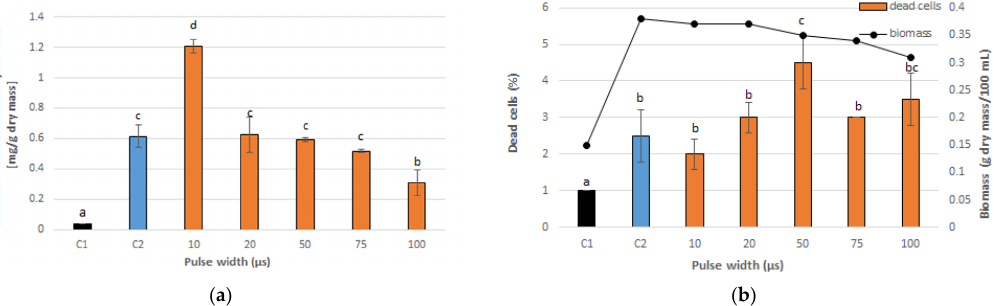
Figure 2. Effect of voltage on vitamin C accumulation in yeast cells ( a ). Effect of voltage on the number of dead yeast cells and on biomass ( b ). C1—control culture without vitamin C added to the medium and PEF treatment, C2—control culture with vitamin C added to the medium (5 mg/mL medium) and without PEF treatment, orange bars—cultures treated with PEF (vitamin C, 5 mg/mL medium; pulse width of 10 µs; treatment time, 10 min; number of pulses, 600; after 20 h of cultiva- tion). Each value is the mean ± standard deviation ( n = 3). Bars with the same letter (a–d) are not significantly different ( p < 0.05).